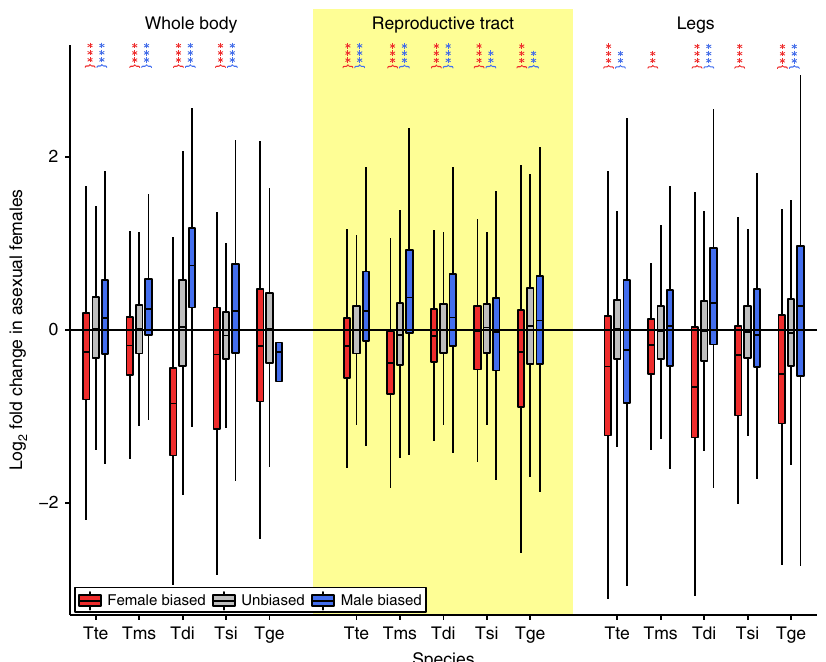
Fig. 2 Expression shifts in sex-biased genes in asexual females. Positive values on the y -axis indicate increased expression in asexual females. Asterisks indicate the signi fi cance level (FDR) of Wilcoxon tests comparing the change in expression in female-biased (red) and male-biased (blue) genes to unbiased genes (***<0.001, **<0.01, *<0.05). Species names are abbreviated as follows: Tte = T. tahoe , Tms = T. monikensis , Tdi = T. douglasi , Tsi = T. shepardi , and Tge = T. genevievae . Boxes represent the interquartile range (25th and 75th percentiles) of the data with the line inside the box representing the median. Whiskers show the most extreme value in the data which is no more than 1.5 times the interquartile range from the box. Source data are provided as a Source Data fi